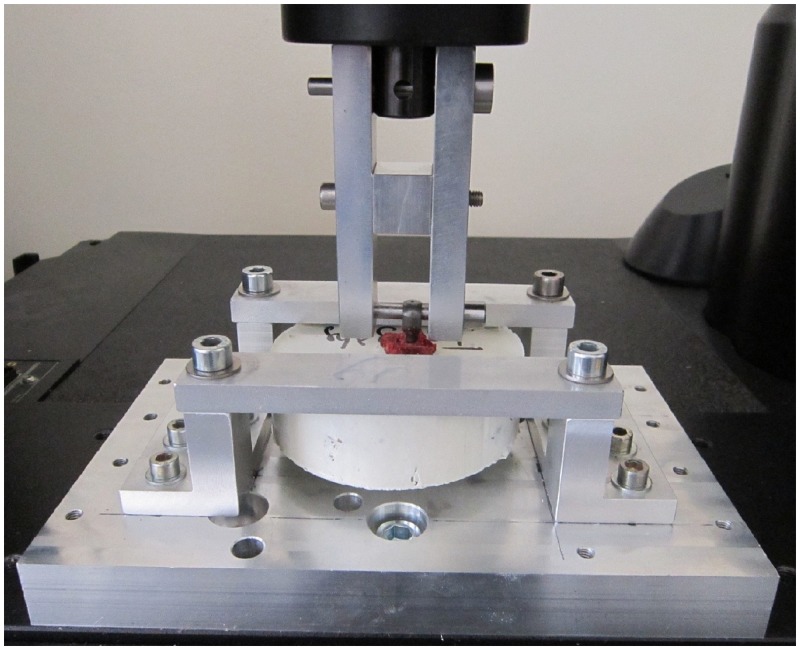
Pullout assembly.